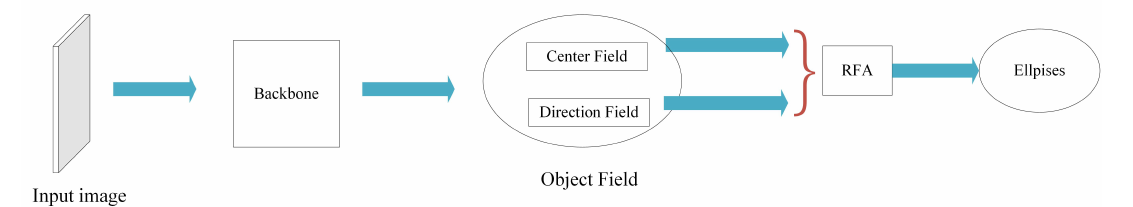
Figure 2. The architecture of Field Network. We add an elliptical field to the output, which contains the Center Field and the Direction Field. The two fields respectively output C feature maps corresponding to the regional distribution field of the C-type